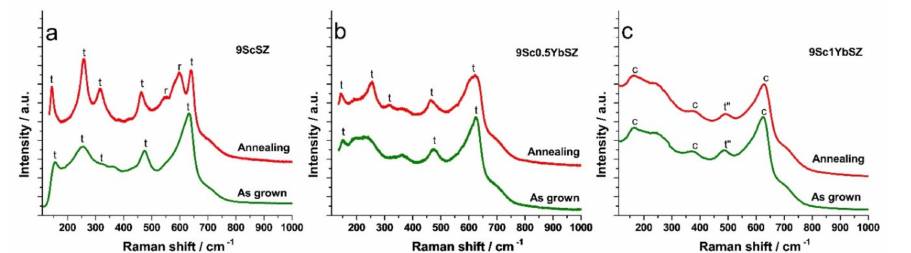
Figure 2. Raman spectra of as-grown and as-annealed ( a ) 9ScSZ, ( b ) 9Sc0.5YbSZ, and ( c ) 9Sc1YbSZ